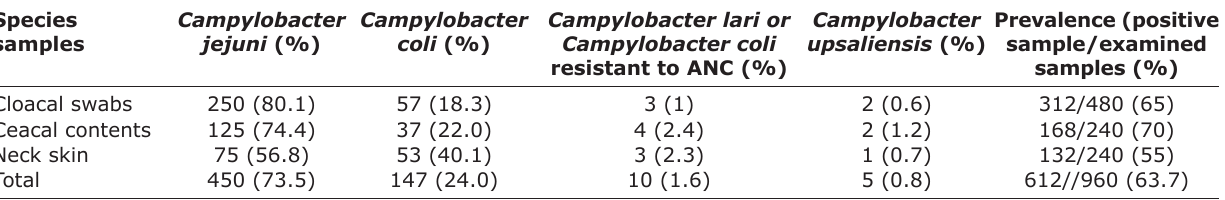
Table-1: Species distribution of Campylobacter isolated from broiler farms and slaughterhouses. Species samples Cloacal swabs